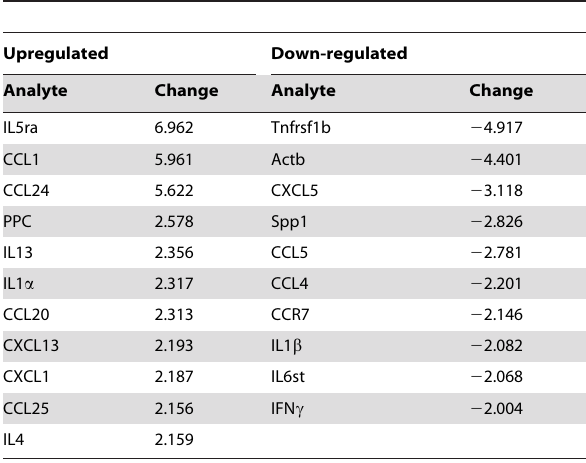
Table 1. Changes in analyte levels in the ileum of three Roquin san/san mice relative to four normal control